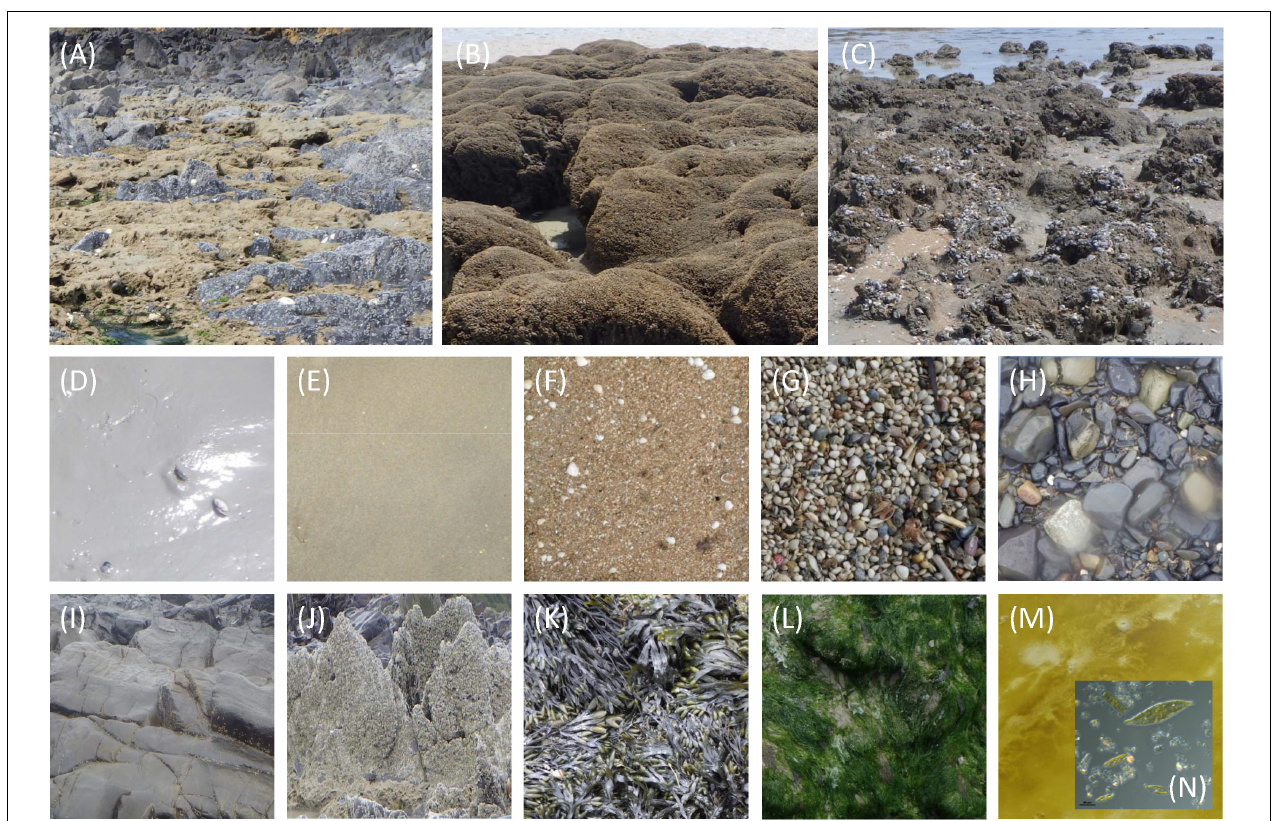
FIGURE 4 | Sabellaria alveolata reef ecosystem benthic features: S. alveolata on rock (A) , healthy S. alveolata on sand (B) , degraded S. alveolata on sand (C) , muddy sediments (D) , sand (E) , coarse sediments (F), shells (G) , pebble and cobble substrates (H) , bare rock (I) , rock with epifauna (J) , brown algae (K) , green algae (L) , microphytobenthos (M) mainly composed of diatoms (N) of the Naviculaceae family and Amphora, Pleurosigma or Gyrosigma